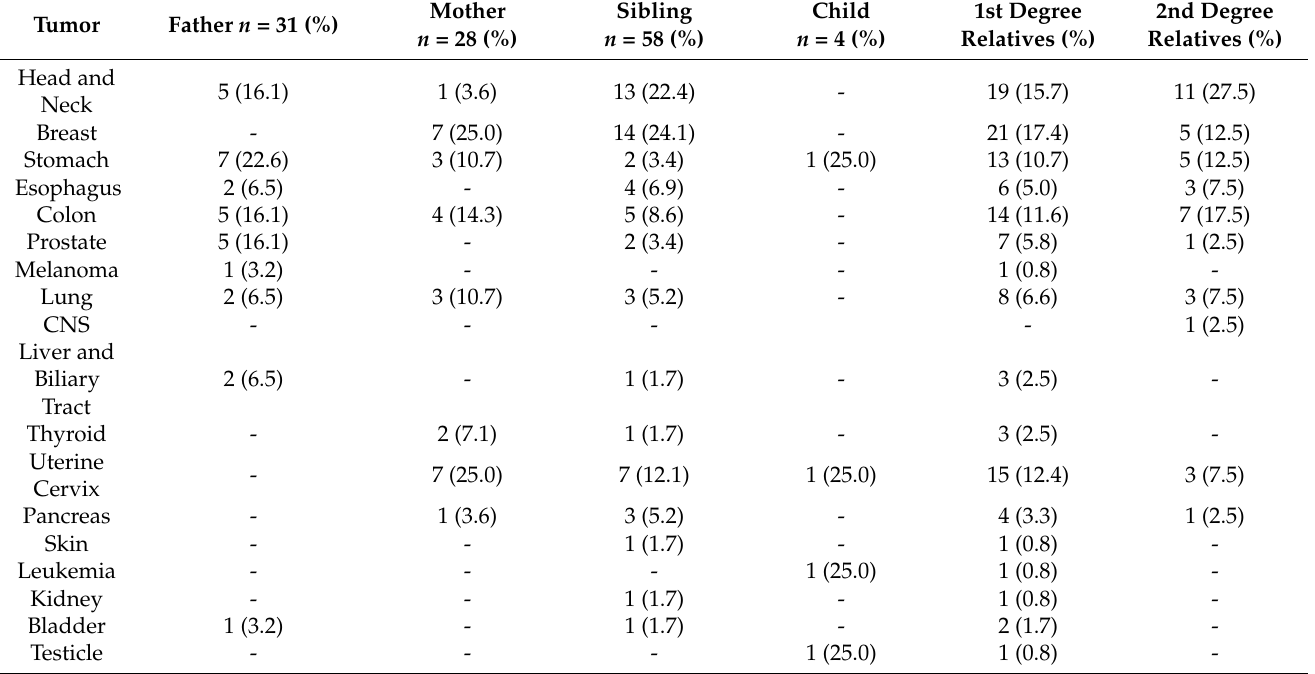
Table 2. Distribution of the tumors among family members of head and neck cancer index